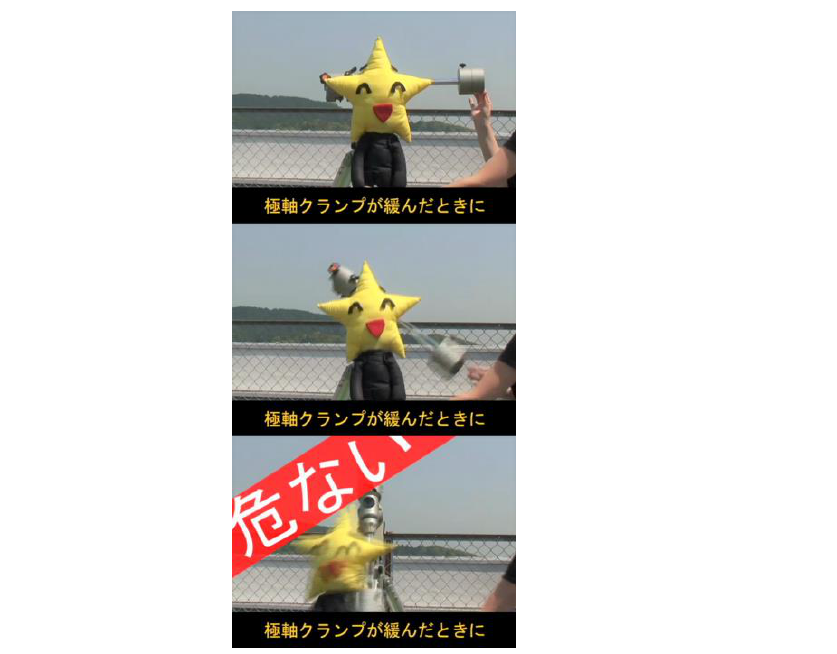
Figure 3. The risk of unsafe attachment of